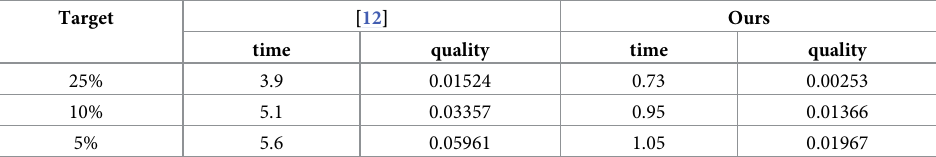
Table 3. Comparison of the timing in seconds and the quality of the simplification of the Gargoyle model using [12] and our proposed